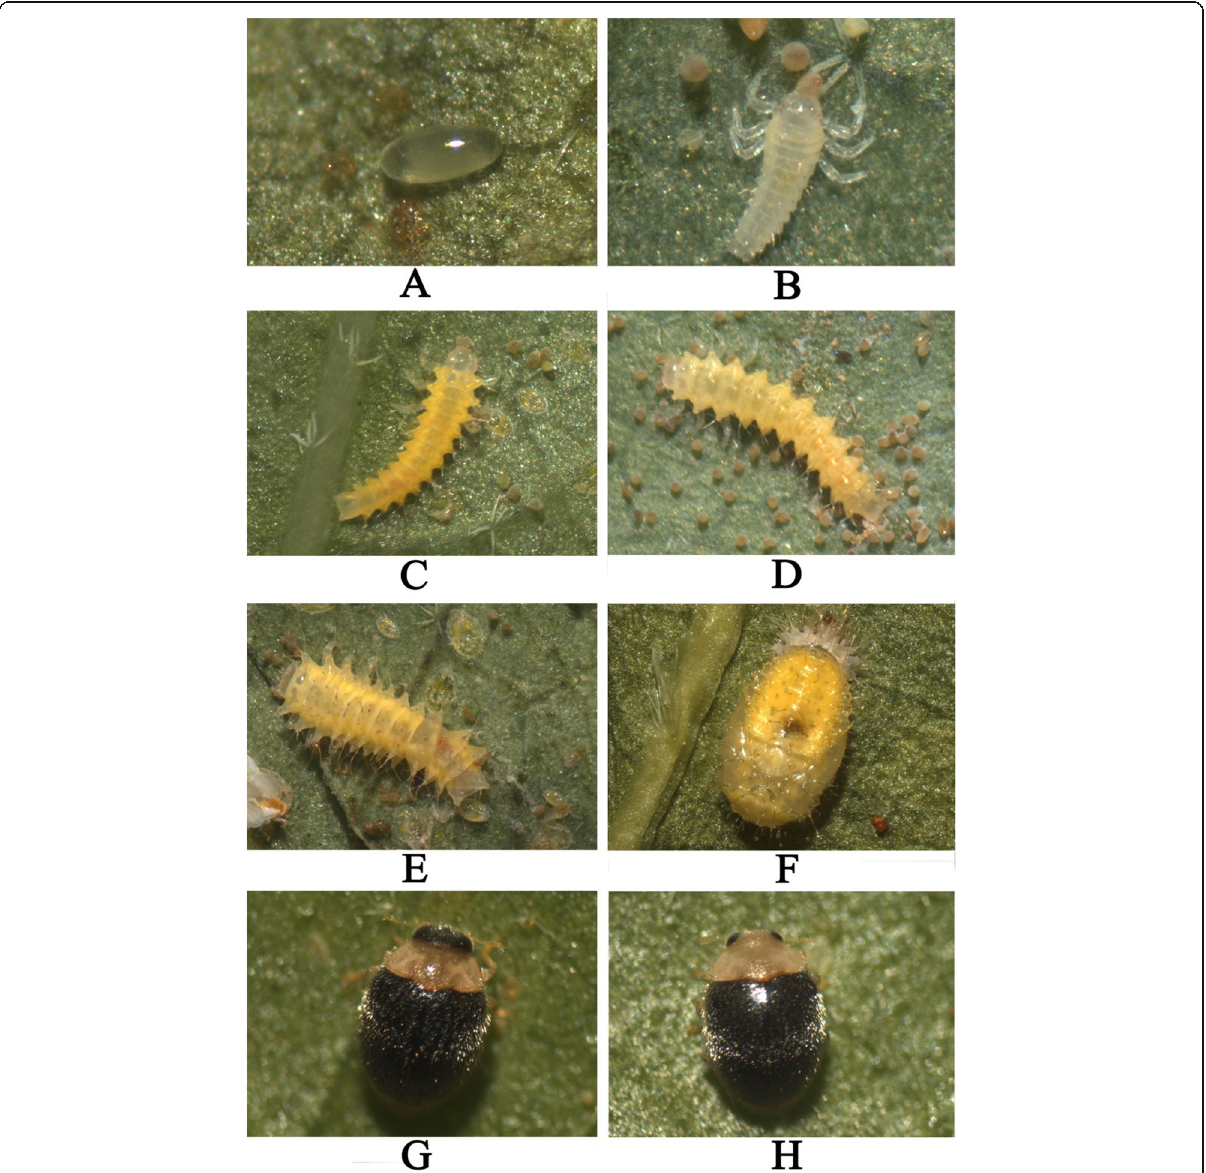
Fig. 1 Life stages of C. brachylobus . a Egg. b First larval instar. c Second larval instar. d Third larval instar. e Fourth larval instar. f Pupa. g Adult female. h Adult